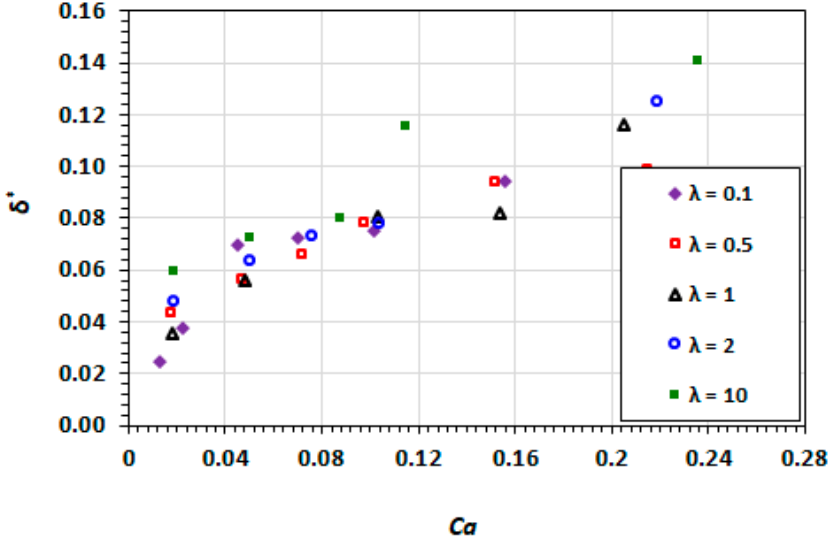
Figure 14. Dependence of the film thickness on capillary number at different viscosity ratios.